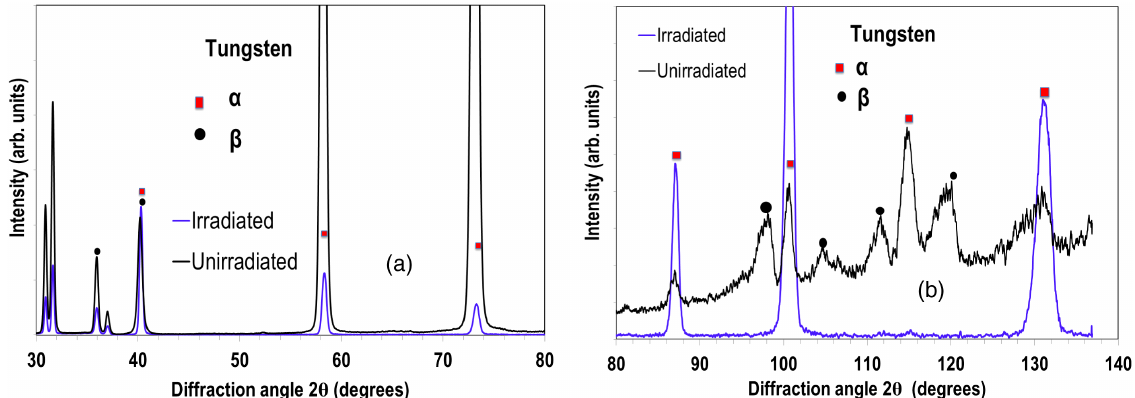
FIG. 29. Irradiation-induced evolution of α and β phases in tungsten. (a) 30 – 80 diffraction angle degree range and (b) 80 – 140 degree